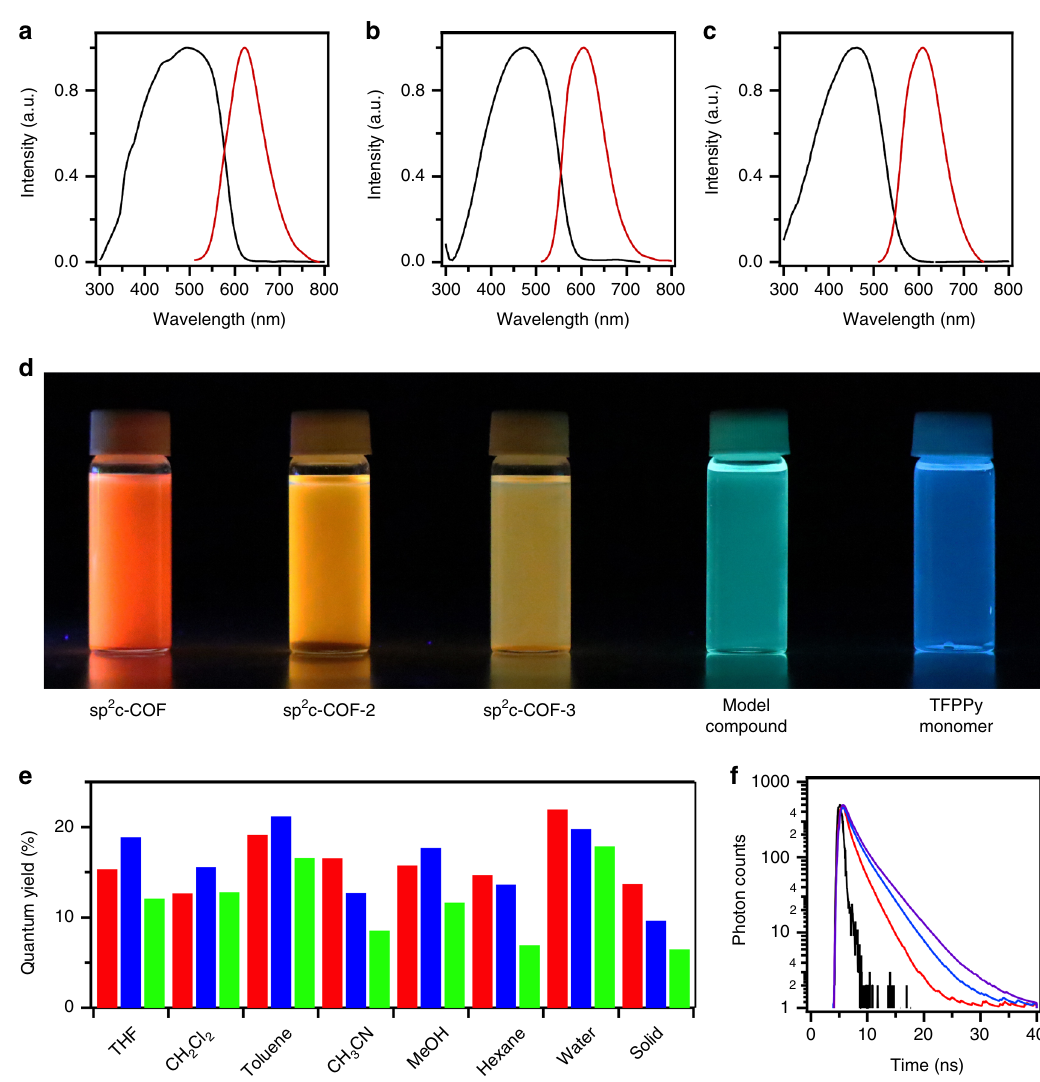
Fig. 5 Light-emitting properties of sp 2 c-COFs. a – c Solid state absorption spectra (black curves) and fl uorescence spectra (red curves) of a sp 2 c-COF, b sp 2 c-COF-2, and c sp 2 c-COF-3. d Photo images of sp 2 c-COF, sp 2 c-COF-2, sp 2 c-COF-3, model compound and TFPPy monomer dispersed in water under a UV lamp. e Absolute fl uorescence quantum yields of sp 2 c-COF (red bars), sp 2 c-COF-2 (blue bars), and sp 2 c-COF-3 (black bars) in different solvents and in the solid state. f Fluorescence decay curves of sp 2 c-COF (purple curve), sp 2 c-COF-2 (blue curve), and sp 2 c-COF-3 (red curve). Black curve is